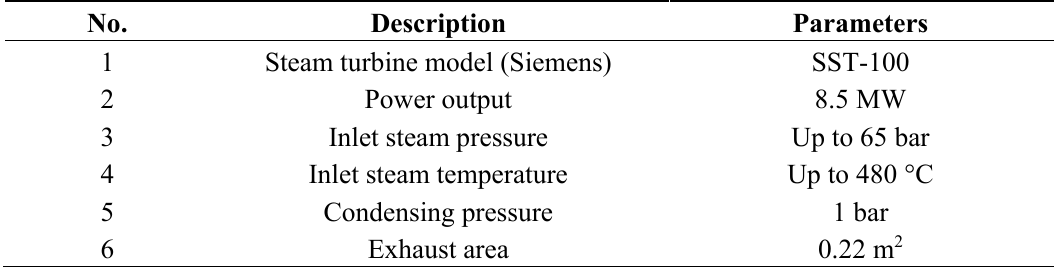
Table 3. Technical specifications of steam turbine [20] (Copyright 2014 Siemens